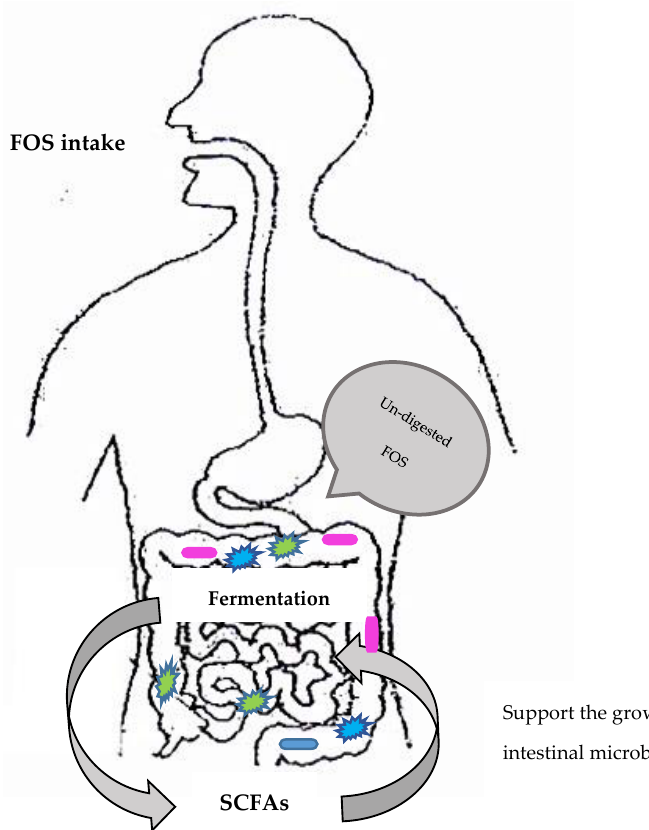
Figure 2. Fructooligosaccharides (FOS) work in the gastrointestinal tract as prebiotics; SCFAs: short chain fatty acids.